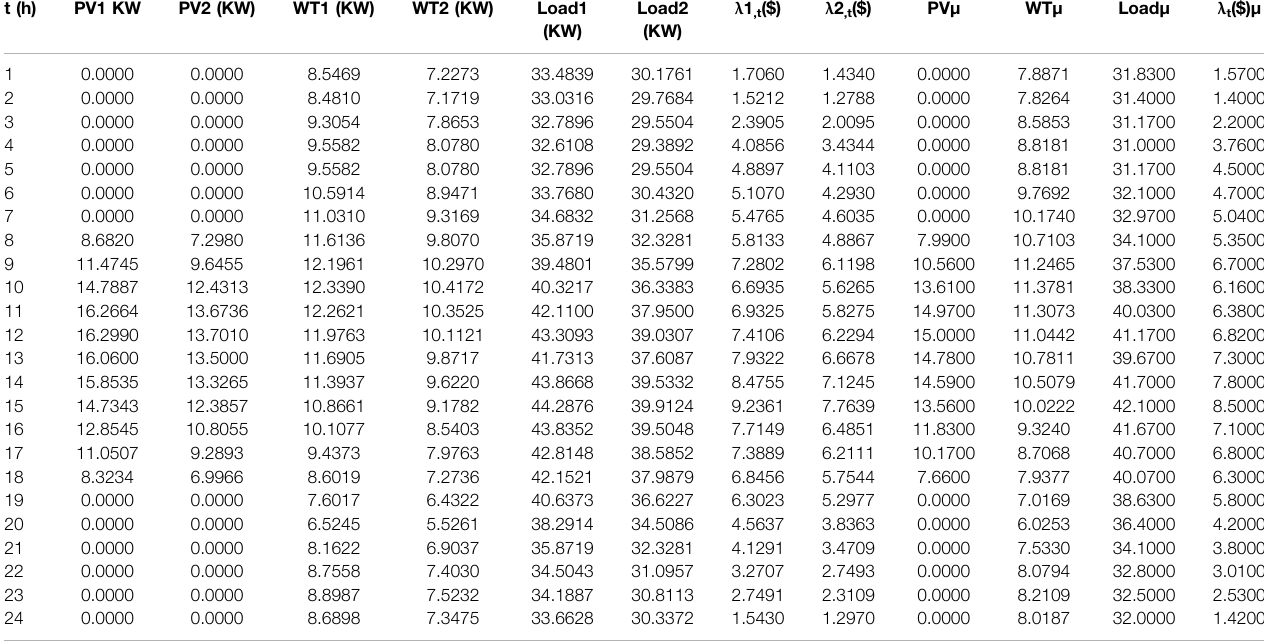
TABLE 12 | Locations of the input random variables for EM and corresponding costs.